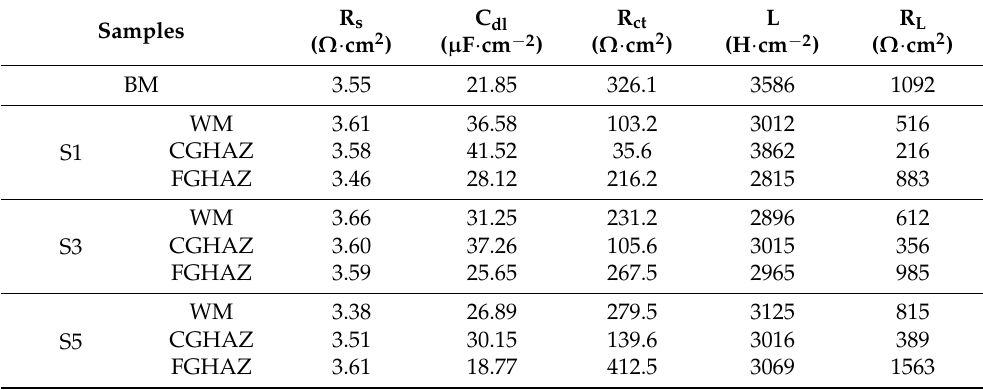
Figure 13. Fitting results of R ct extracted from impedance spectrum curves of different samples. Table 4. The fitted values of EIS for different samples under immersion for 0 h.